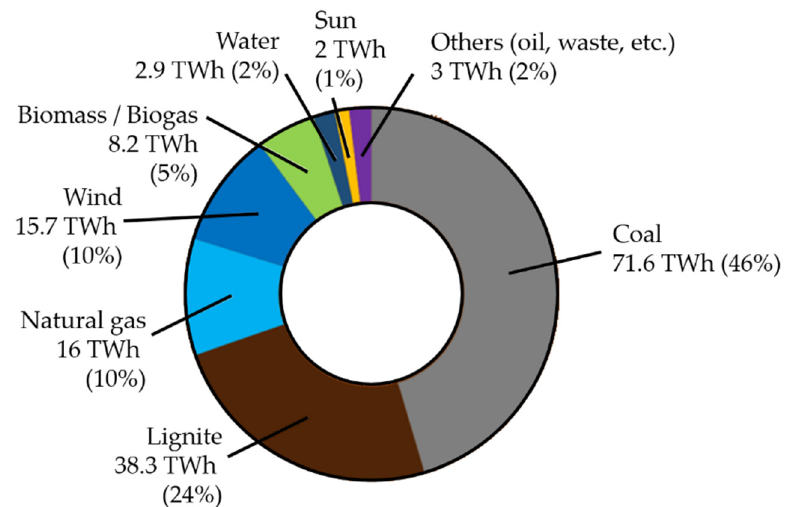
Figure 5. Electricity sources in Poland in 2020.